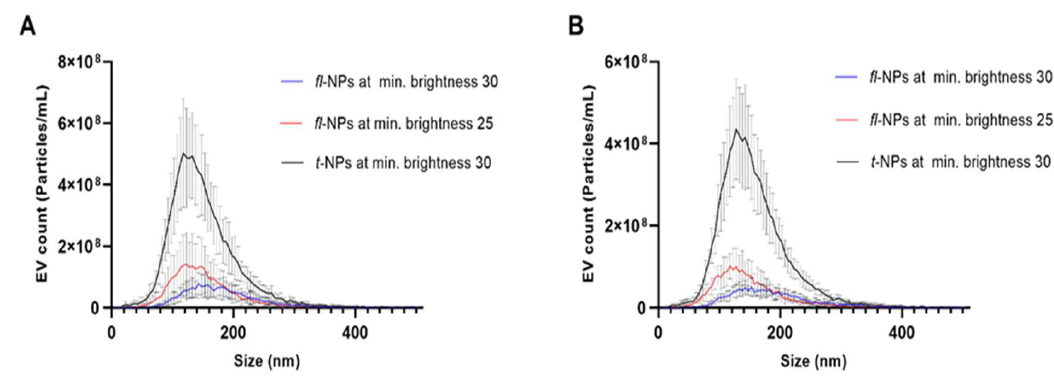
Figure 1. Size profiles of CMG labeled fluorescent and total NPs originated from JAr and HCT116 cells measured at 30 and 25 minimum brightness threshold values using Zetaview ® -NTA. Size profile distribution for CMG-labeled fl -NPs and t -NPs of JAr ( A ) and HCT 116 ( B ) EVs diluted in 1 × PBS at scattering and fluorescent NTA measurements. (Mean ± SD, n = 9).